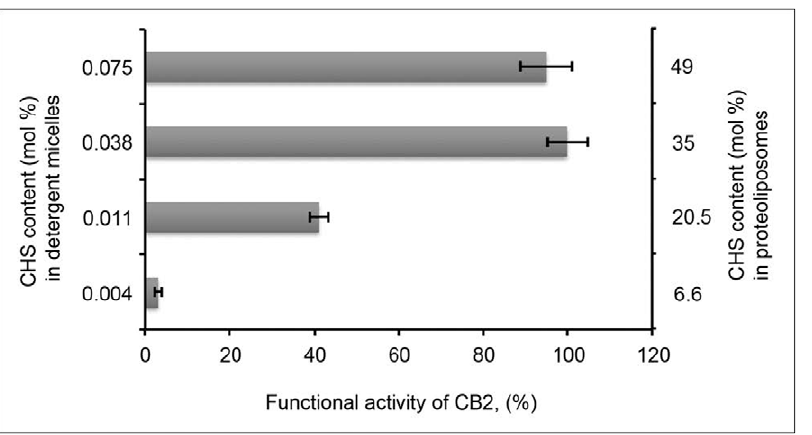
Figure 4. Functional activity of CB 2 in proteoliposomes. Dependence of functional activity of CB 2 on CHS content in detergent micelles and in proteoliposomes. The sample with the highest activity within this series (0.1% CHS in micelles) is shown as 100% of activity. The figure depicts data 6 SD (error bars) of duplicate measurements from representative experiments (n=3).